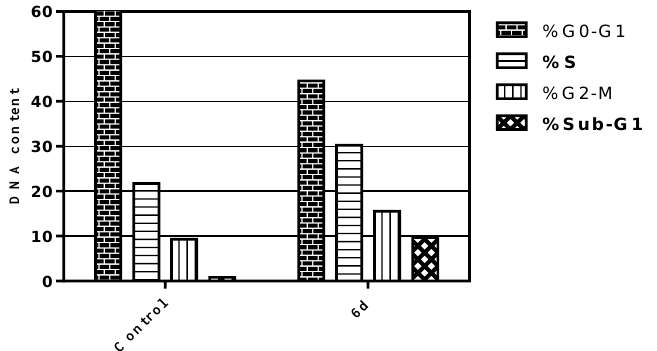
Figure 2. Effect of 7d on the cell cycle phases within MCF-7 cells after treatment for 24 h at the IC 50 concentration.